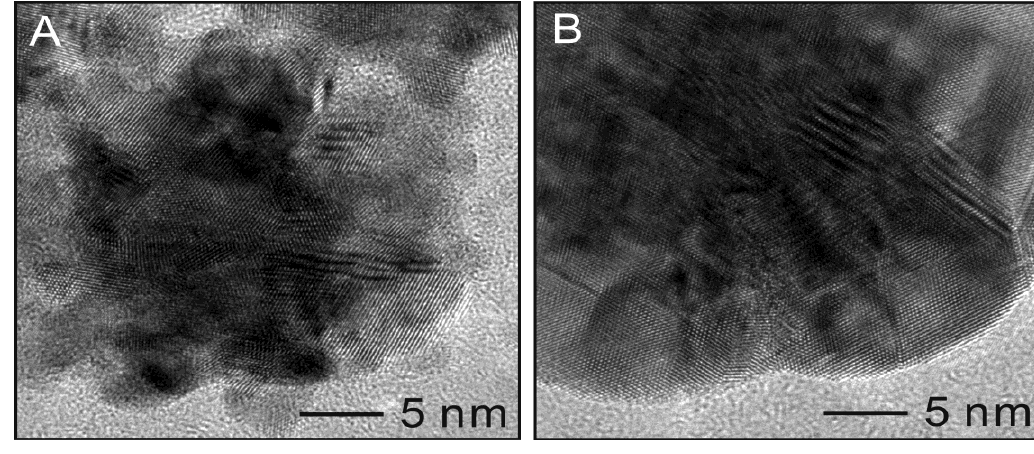
Figure 6. HRTEM images of a bare platinum (25.7 nm) NP ( A ) and for a Pt